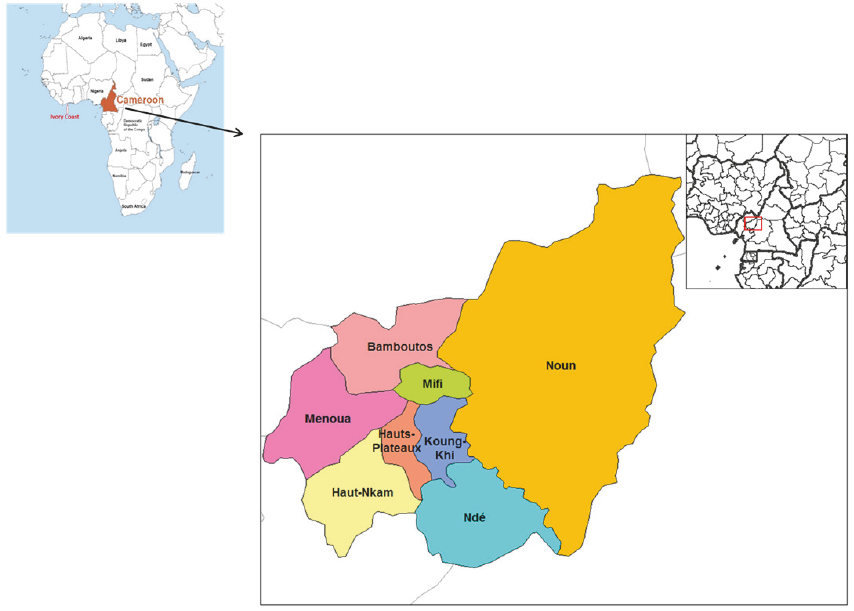
Figure 1: Map showing Bamboutos Division in the West Region of